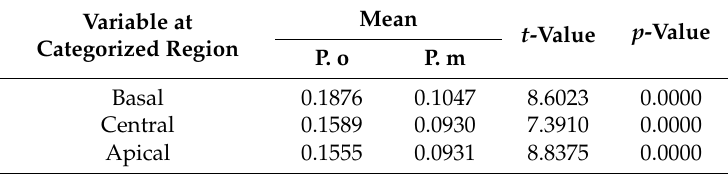
Table 1. Values of Student’s t -test for the mean thickness of the outer parenchyma zone for the three regions (basal, central, and apical) along the shoots of P. odoratum (P. o) and P. multiflorum (P. m). Mean Variable at t -Value p -Value Categorized Region P. o P. m Basal 0.1876 0.1047 0.0000 Means are expressed in mm, n = 15.